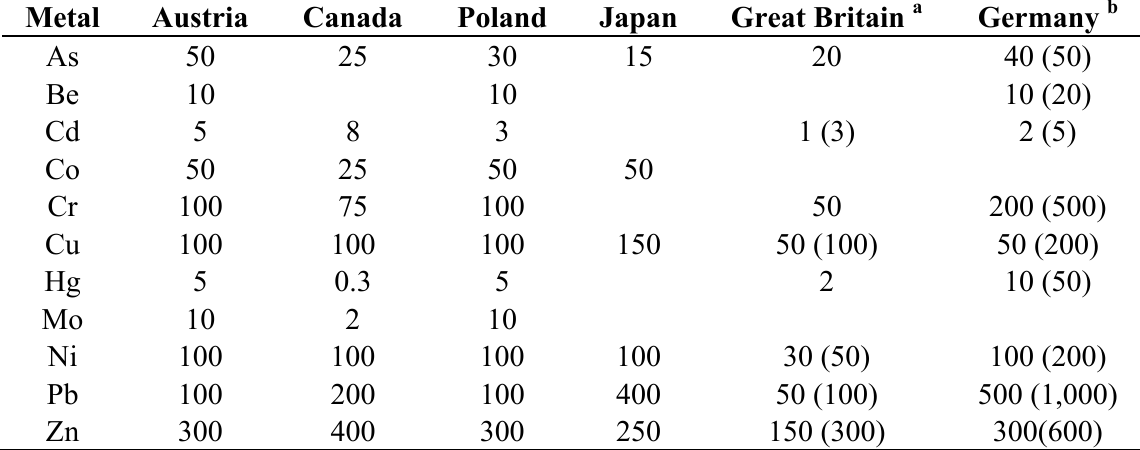
Table 5. Proposal for maximum acceptable concentrations (MAC) of trace metals considered as phytotoxic in agricultural soils (mg/kg).